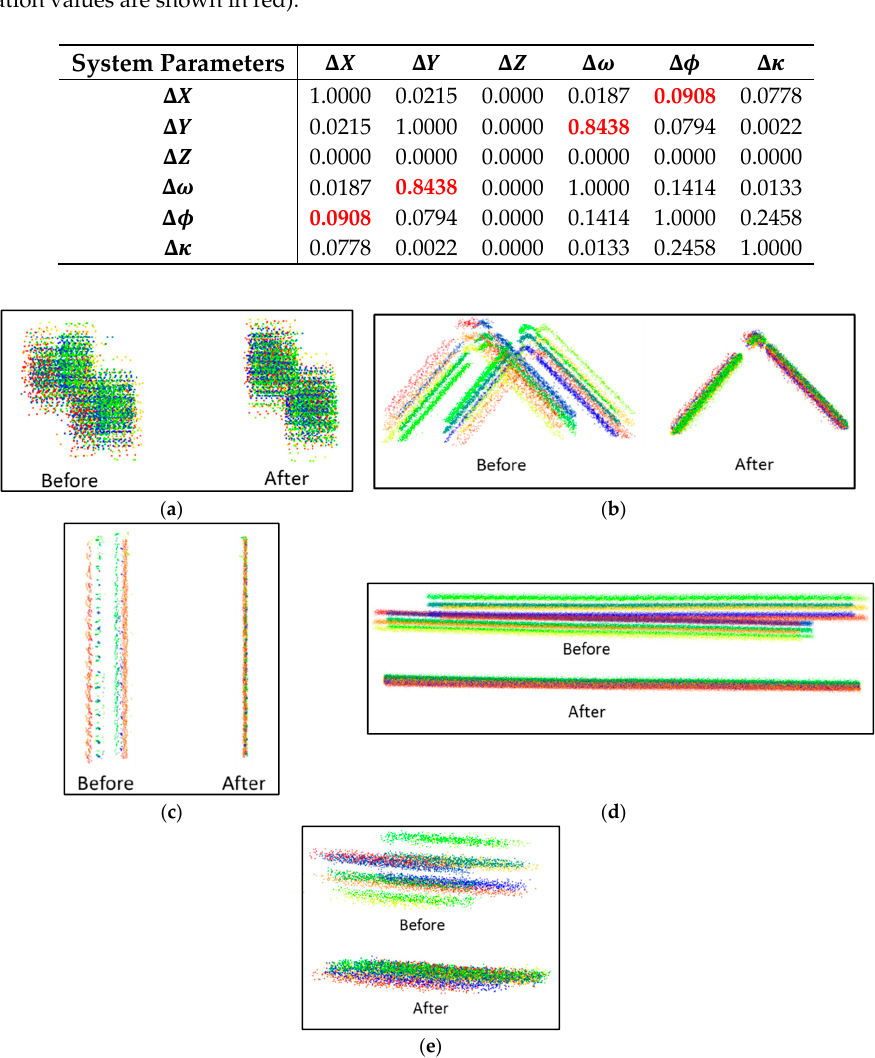
Figure 11. Qualitative evaluation of calibration targets before and after calibration: ( a ) Checkerboard target; ( b ) hut-shaped target; ( c ) building façade; ( d ) ground patch; and ( e ) highly reflective sign board. Table 8. Calibration of the UAV system: Square root of the a-posteriori variance factor ( (cid:2026)(cid:3548) (cid:3042) ) and RMSE of plane/line fitting for different configurations.